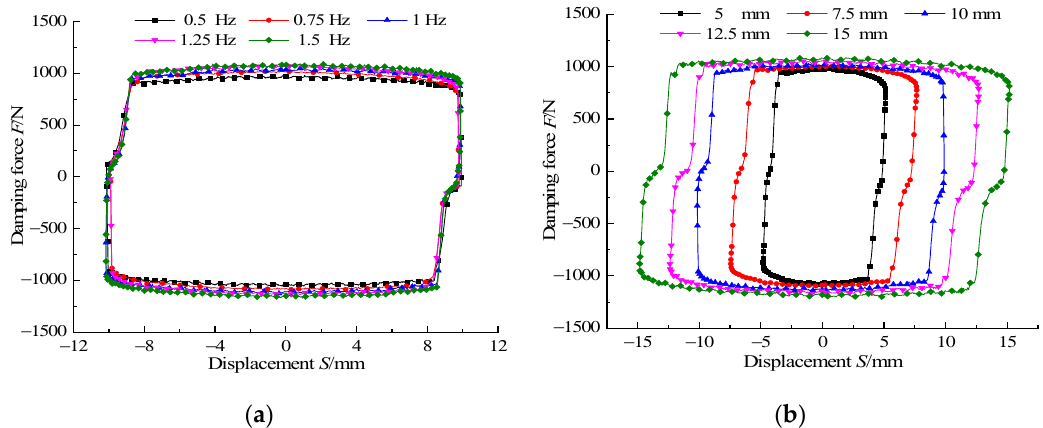
Figure 20. Damping force versus displacement at different sinusoidal excitation at ( a ) different frequencies and ( b ) different amplitudes.